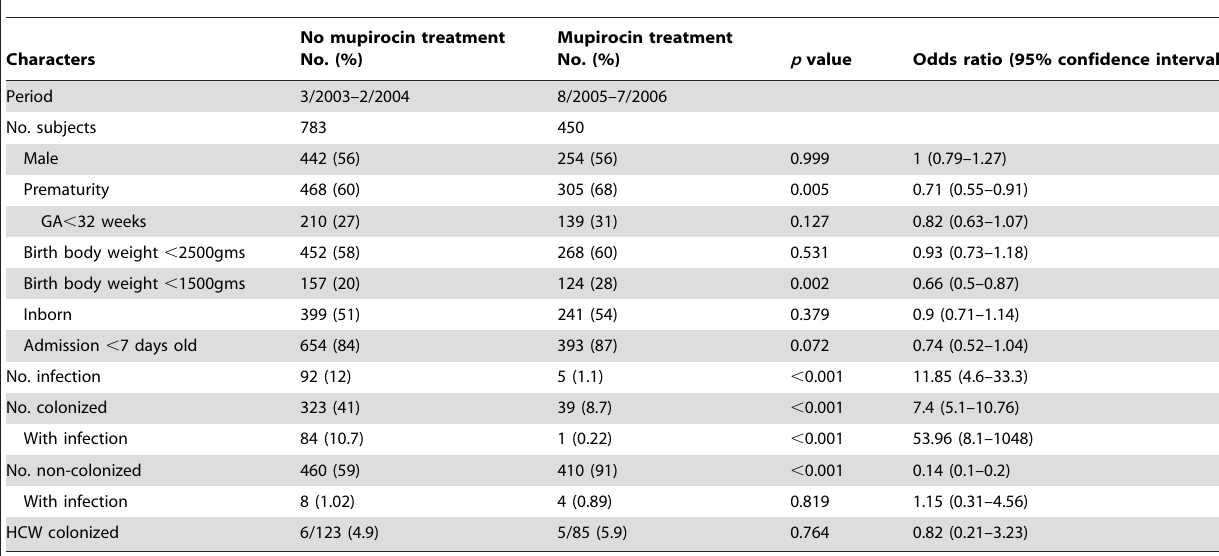
Table 3. Comparison of methicillin-resistant Staphylococcus aureus colonization and infection between the infants hospitalized at neonatal intensive care units with and without mupirocin